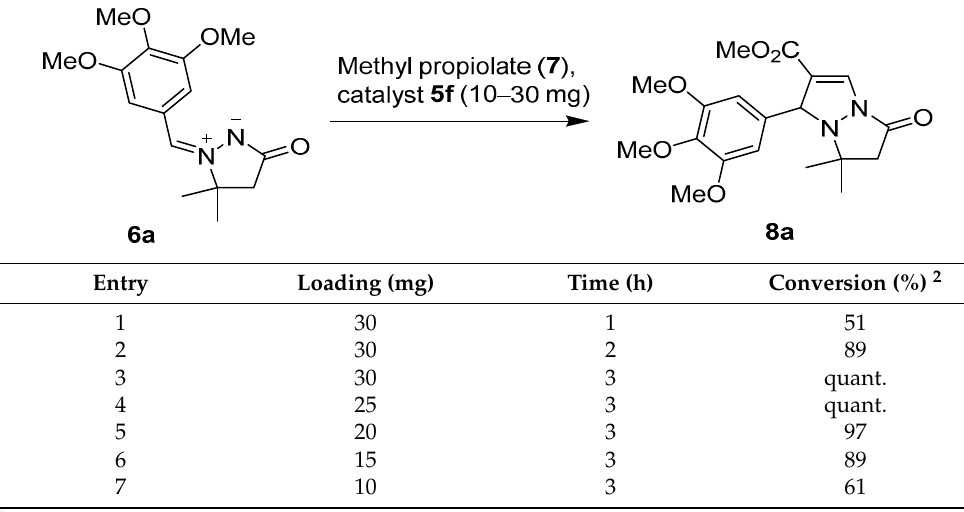
Table 2. Evaluation of catalyst 5f in model cycloaddition reaction 1 .